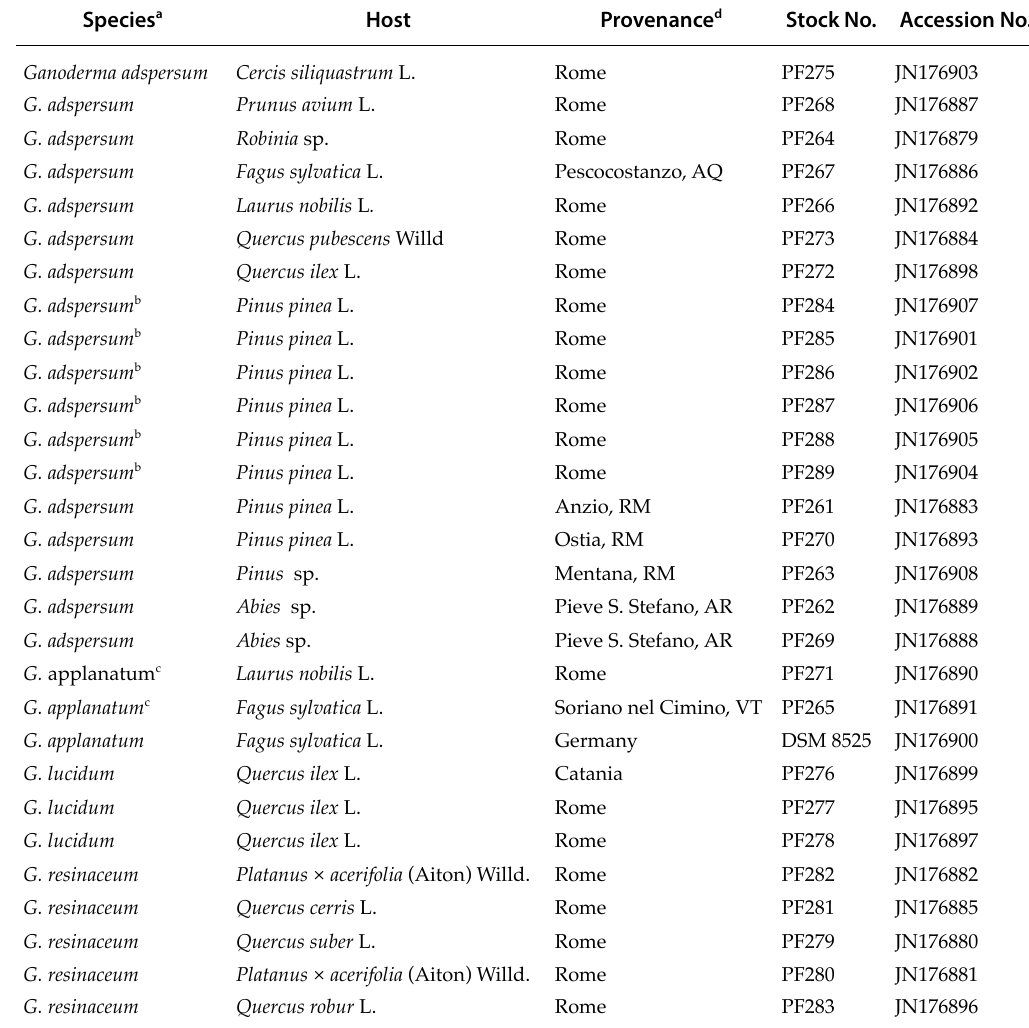
Table 1. List of fungal isolates analyzed in this study. Hosts, provenance, collection numbers and Genbank accession num- bers are